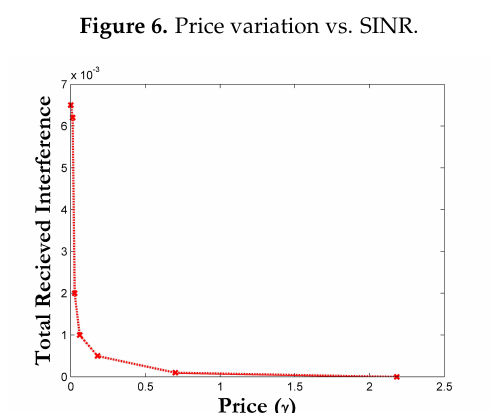
Figure 7. Total interference at